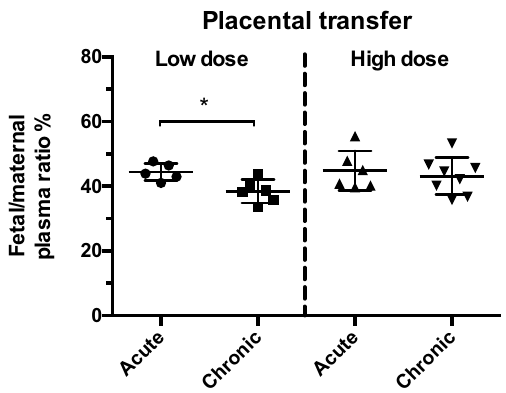
Figure 4. Placental transfer of 3 H-paracetamol at E19. Fetal/maternal plasma concentration ratio (%) for low and high dose paracetamol labelled with 3 H following acute or chronic treatment. The low dose chronic treatment group had a ratio (38%) that was significantly below the acute low dose group. Overall the other ratios were about 45%. Symbols are plasma samples from individual pups. Mean ± SD; n = 5–8. *p < 0.05. High dose data from (Koehn et al. 2 ).